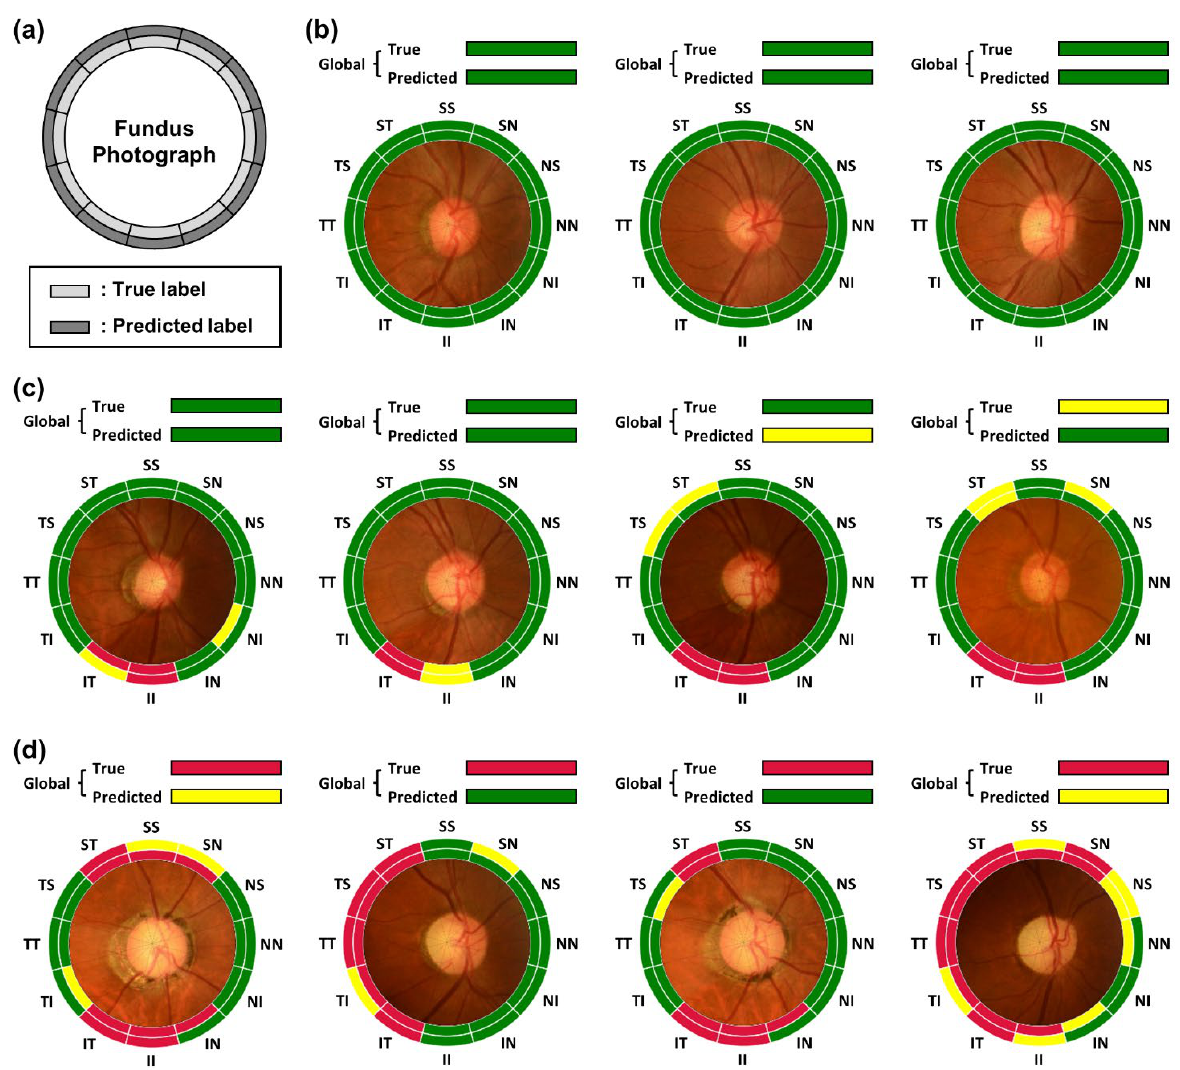
Figure 4. Evaluation of the labeling results of RNFL thinning level with representative examples. ( a ) Representation format. The inner color label indicates the true thinning level from OCT measurement and the outer color label is the predicted level from CNN estimation. ( b ) All normal, ( c ) partially damaged, and ( d ) severe cases. Data is based on the test set.